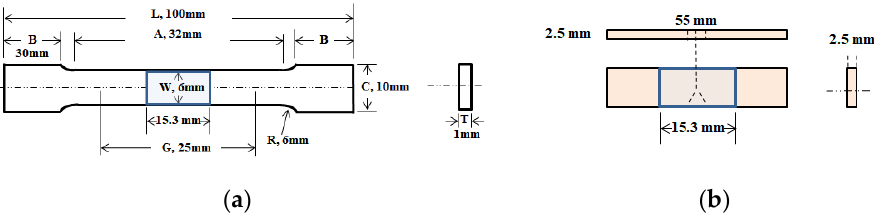
Figure 3. DED 3D printing specimen design with FGM (shaded area): ( a ) plate tensile specimen; ( b ) 1/4 thickness sub size impact test specimen.